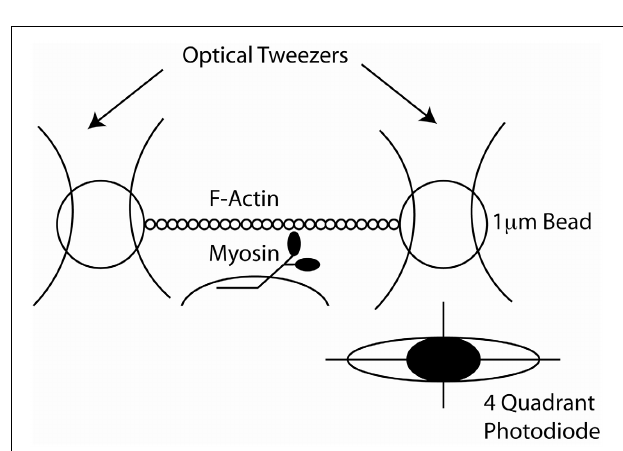
FIGURE 4 | Cartoon of the sliding actin in vitro motility assay. Upper panel : cartoon of the design of the flow chamber for the assay. A nitrocellulose coverslip is supported by two strips of double sticky tape to create a flow chamber. Myosin is bound to the coverslip and fluorescently-labeled actin filaments are introduced. The reaction is typically started by the introduction of ATP-containing buffer. Lower panel : Cartoon of the surface of the coverslip. The bound myosins interact with the actin filament and translocate.